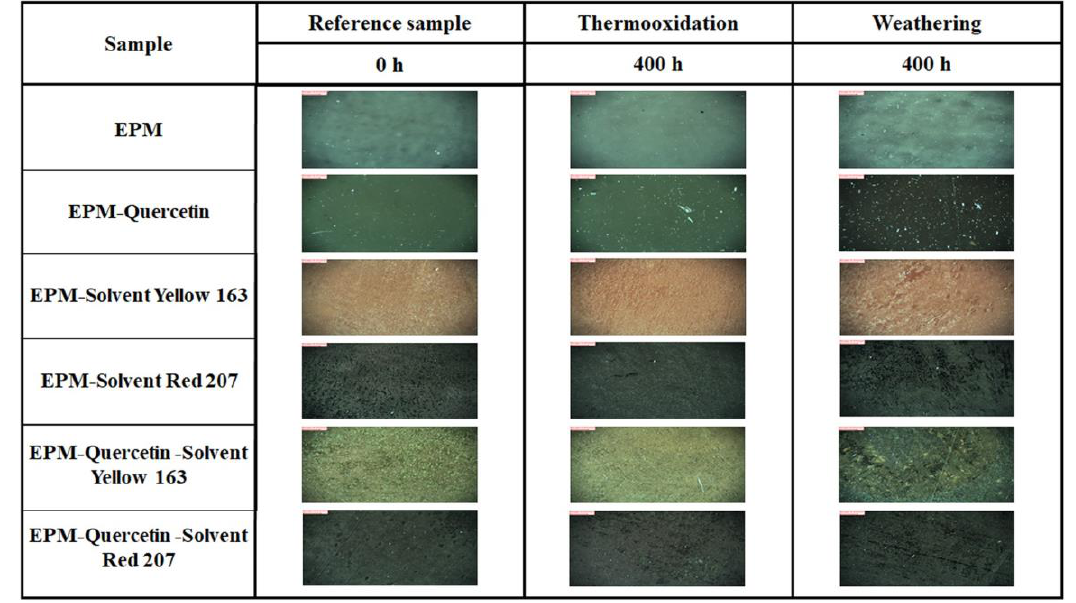
Figure 10. Effect of thermo-oxidation and weathering aging on the surface properties of EPM-based composites examined by optical microscopy at 130× magnification.